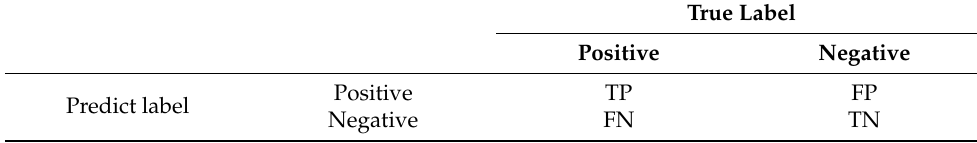
Table 2. Description of TP, TN, FP, and